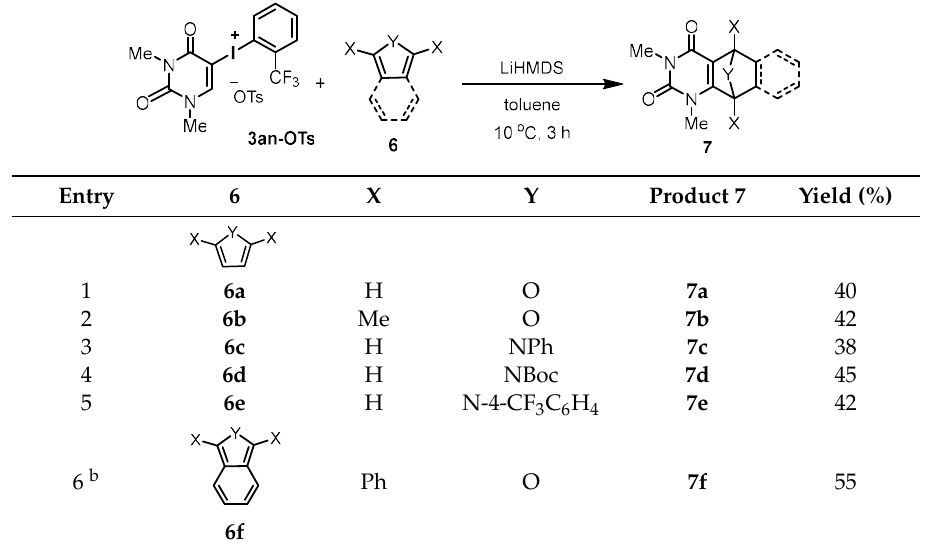
Table 4. [4 + 2] Cycloaddition using uracil-iodonium(III) salt 3an-OTs a .